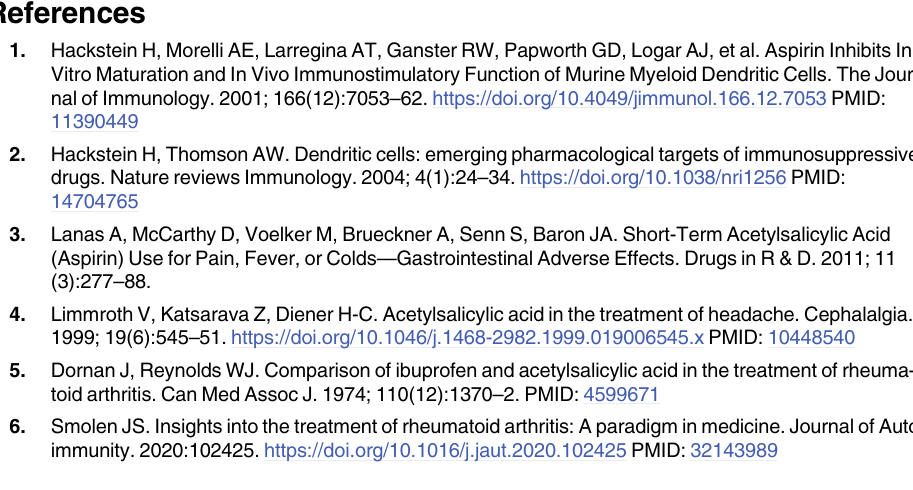
S4 Table. Effect of Indomethacin and Celecoxib on TLR-ligand induced cytokine release. S5 Table. Inhibitory effect of acetylicsalicylic acid, Indomethacin, and Celecoxib on TLR- ligand induced PGE production. 2 S6 Table. Effect of exogenous addition of PGE on immunomodulatory properties of ace- 2 tylsalicylic